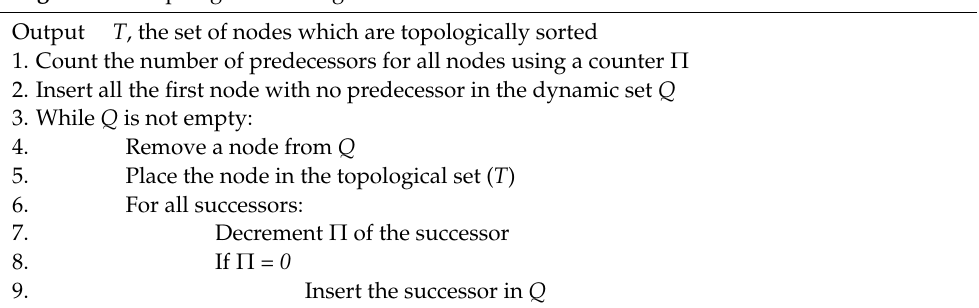
Algorithm 2 Topological Sort Algorithm